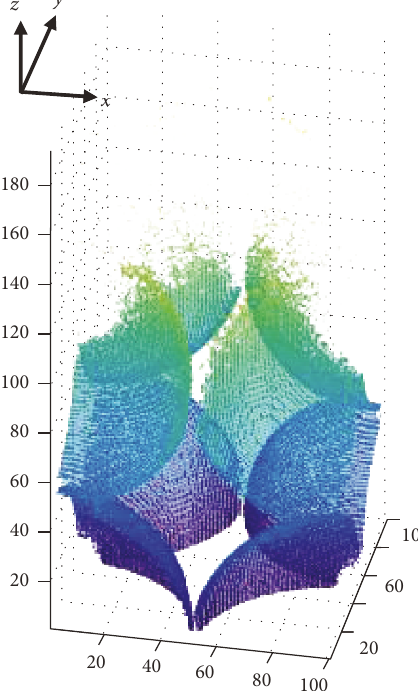
Figure 8: Locations where the simulated Brownian motions stop, i.e., points on the surfaces of the void-solid interface on the 100 × 100 × 300 grid. The colors from blue to green-yellow indicate the increasing z values. Figure 7). The blue lateral faces are cut sections of the void, which are treated as a no- fl ux boundary due to the void symmetry within the entire medium.